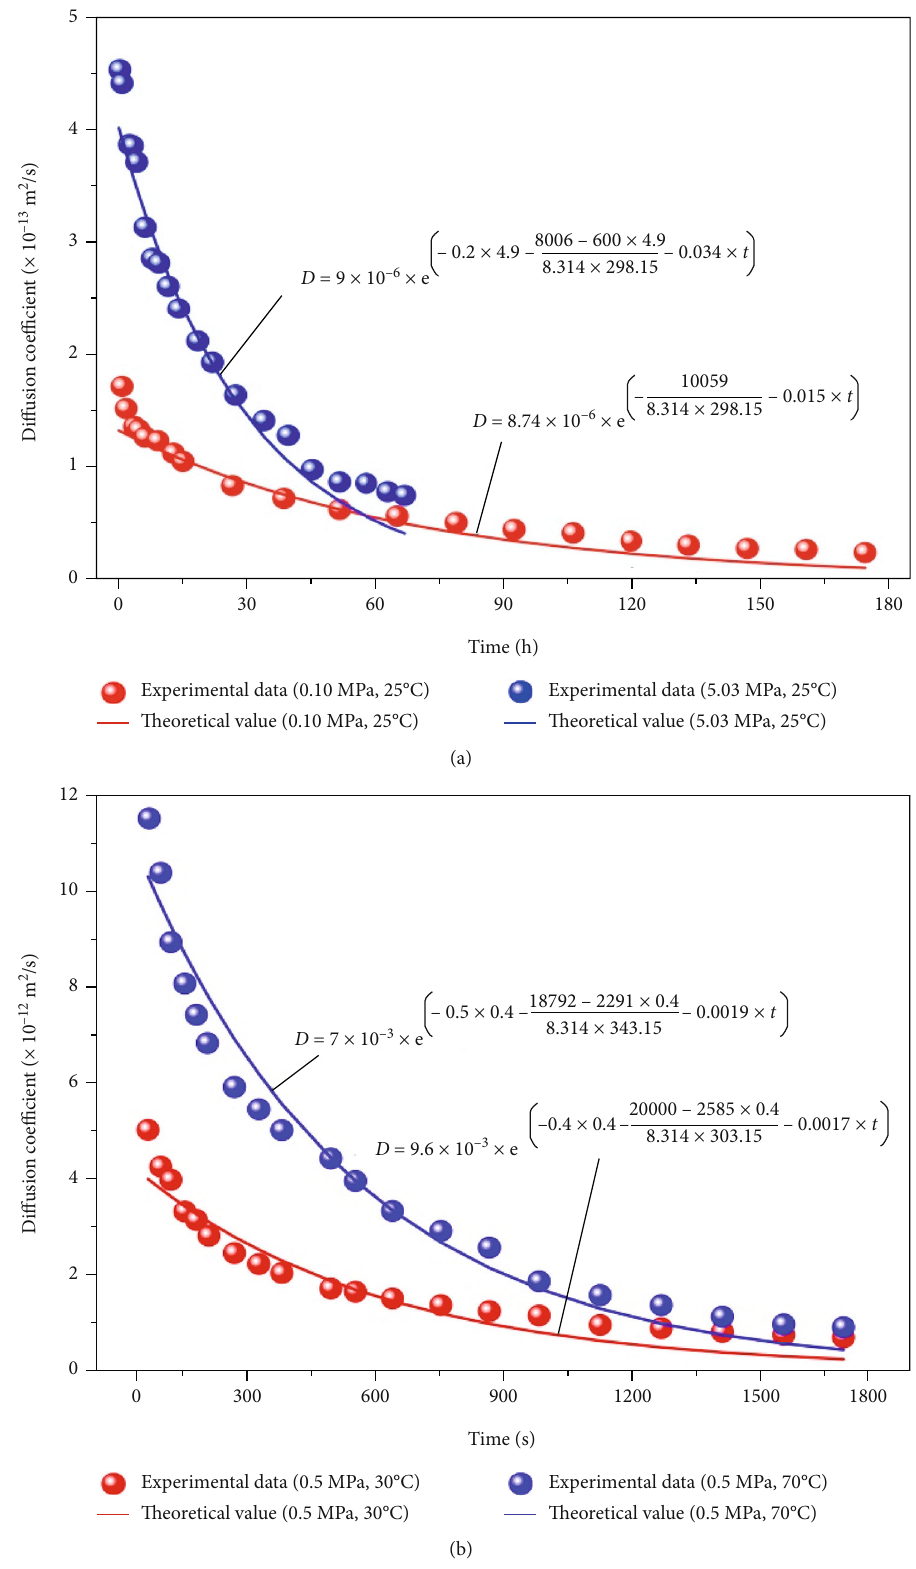
Figure 5: Fitting results of our di ff usion model with the experimental data from (a) Ma et al. [45] and (b) Charriere et al.